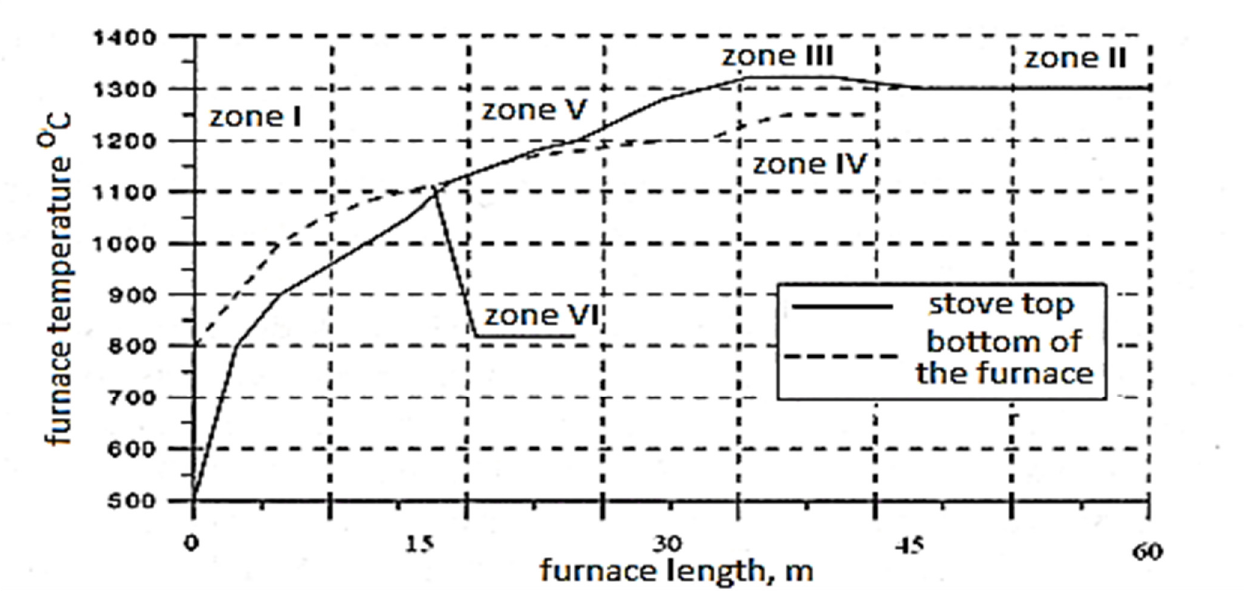
Figure 8. Ingot heating curves in the walking beam furnace of the hot strip mill for asymmetric distribution of the furnace temperature above the charge and under the charge. Source: own study.